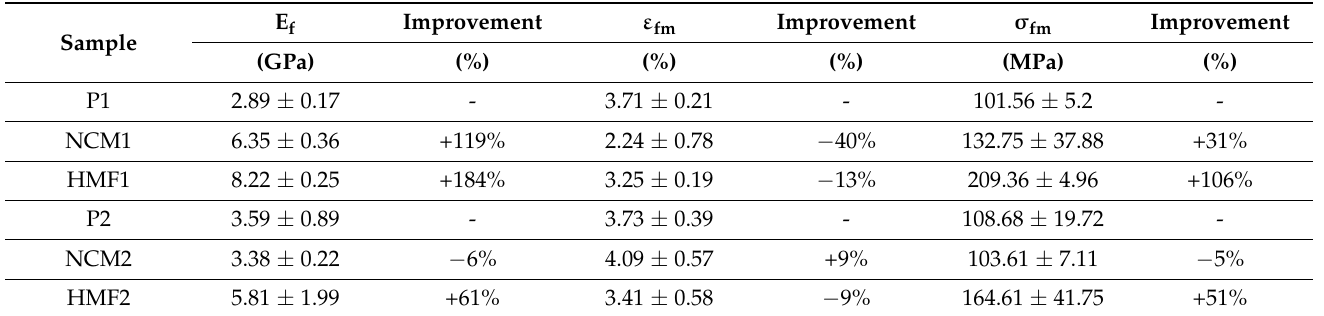
Table 3. Results of bending test analysis of the obtained